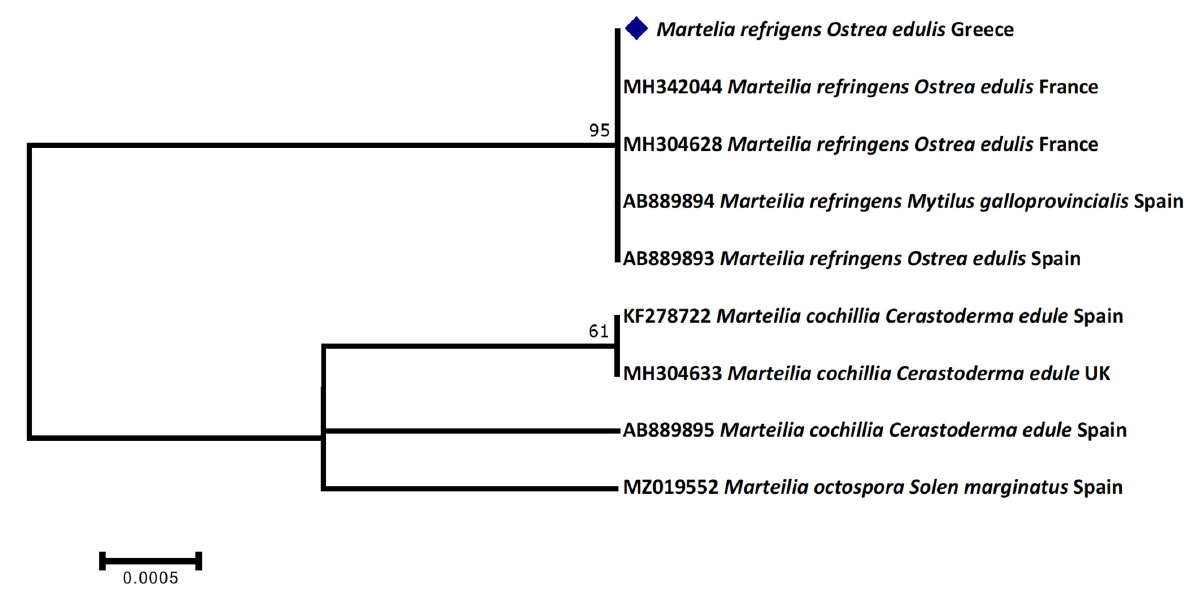
Figure 2. Maximum likelihood phylogenetic tree of the Marteilia refrigens strain detected hosting Ostrea edulis in comparison to congeneric strains from GenBank.